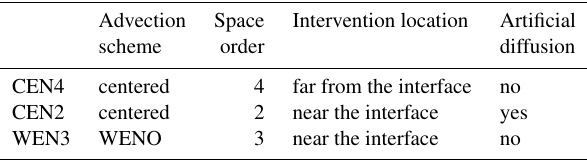
Table B1. Summary of the mean wind advection scheme used (WENO: weighted essentially